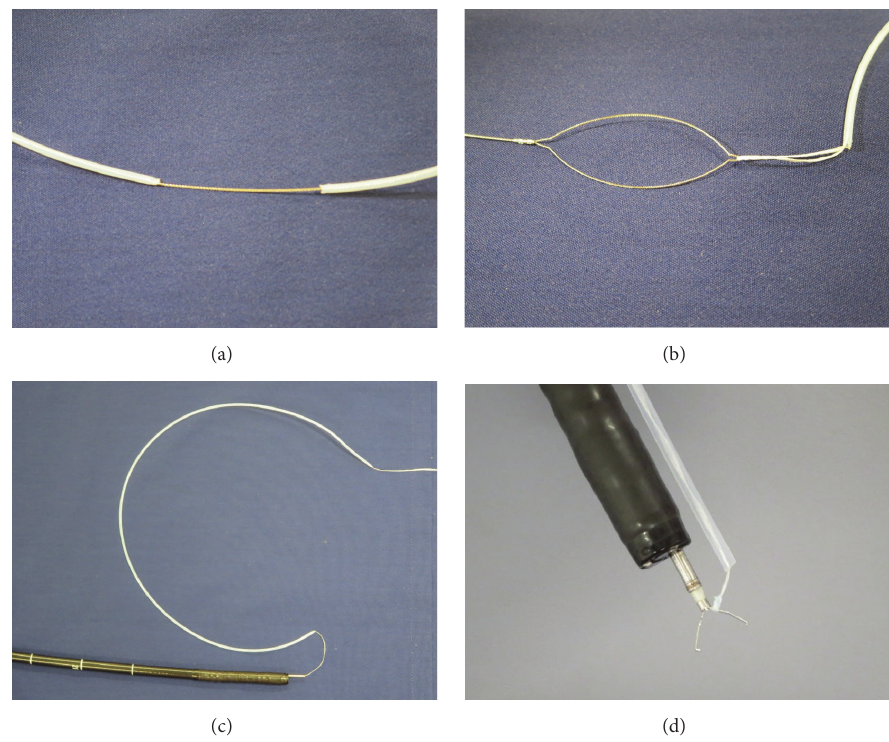
Figure 2: Preparation for thread-traction using a sheath of polypectomy snare (part 2). The sheath of the snare is cut at about 60 cm with scissors (a). The polypectomy snare holding the thread is gradually retrieved, and the thread completely passes through the sheath of the snare (b and c). The sheath of the snare is positioned close to the clip (c). The endoscope and the sheath containing the thread are simultaneously inserted into the stomach (d).